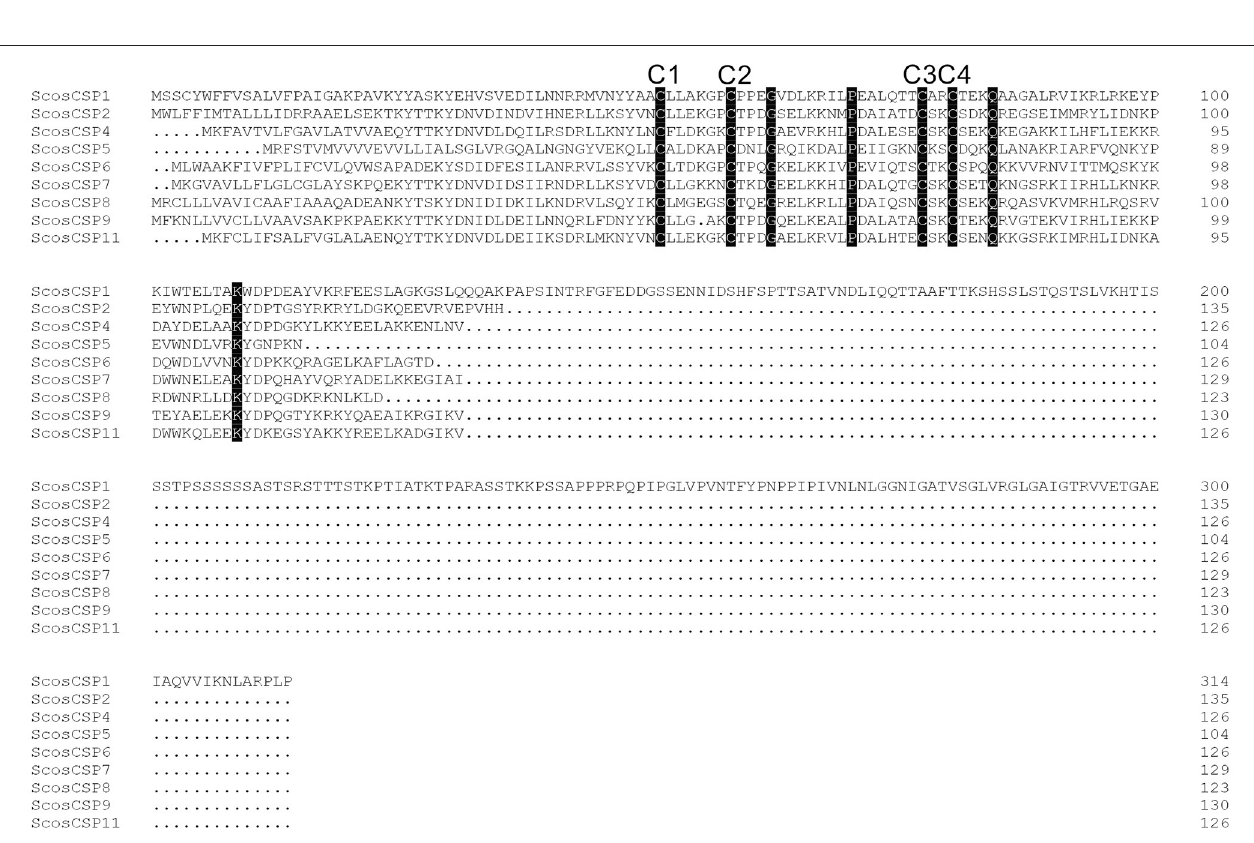
FIGURE 6 | Sequence alignment of candidate ScosCSPs. The four conserved cysteine residues are marked as C1–C4. Additional residues that conserved in this species were also